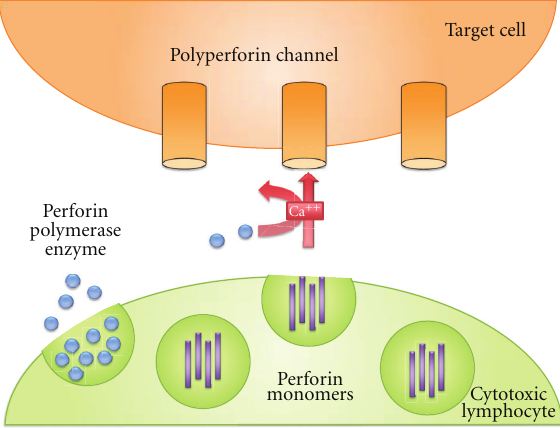
Figure 2: Perforin is the primary mediator of injury by CD8 + T cells. Perforin is the primary molecule known to mediate injury by CD8 + T cells. Perforin mediates axonal transection in multiple sclerosis (MS) and correlates with neurological disability. Cytotoxic T cells secrete perforin in the form of granules along with granzymes. This release activates calcium, which results in “poly-perforin” channels on the target cells. This results in holes in the membrane of the target cells, causing leakage of intracellular material, which results in cell